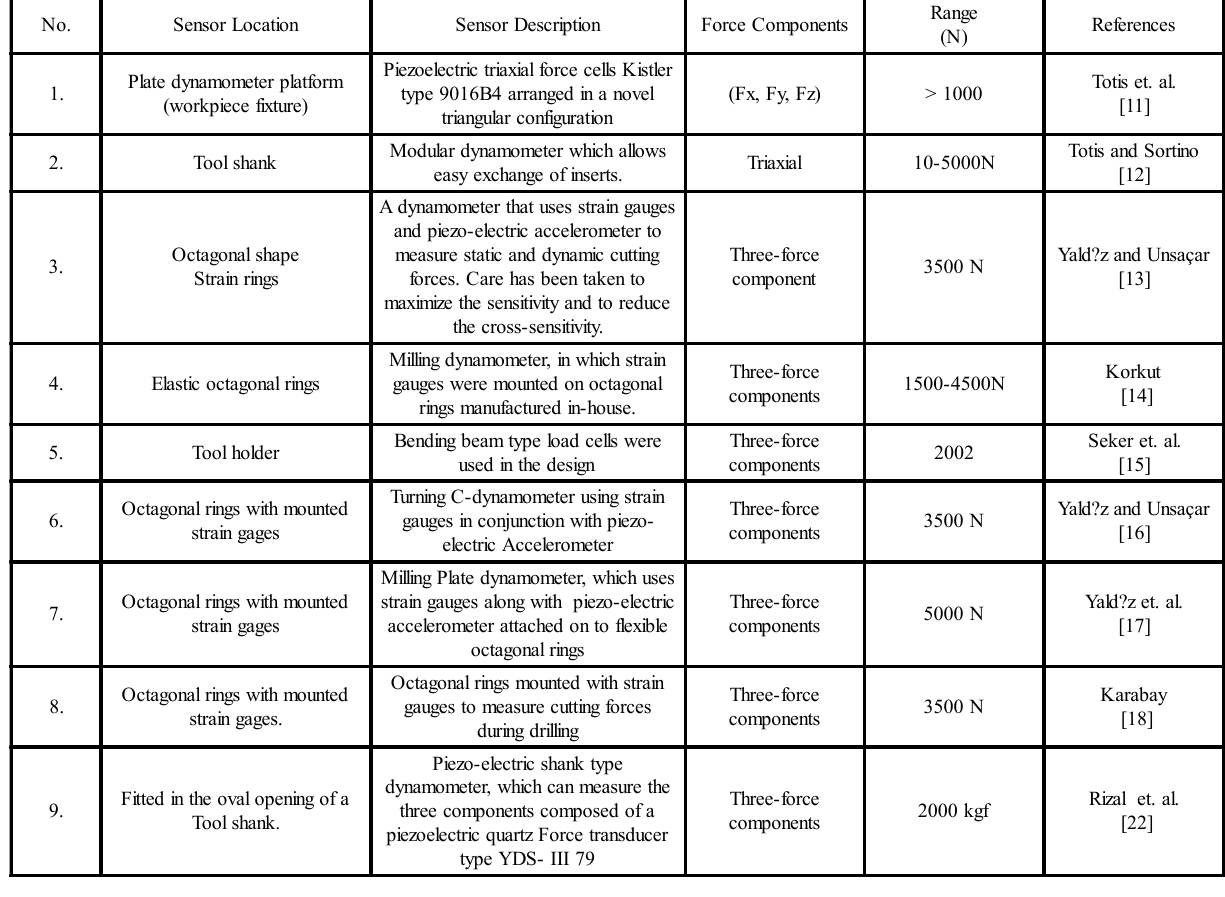
TABLE 1. SUMMARY OF WORK DONE TO DEVELOP DYNAMOMETER IN THE